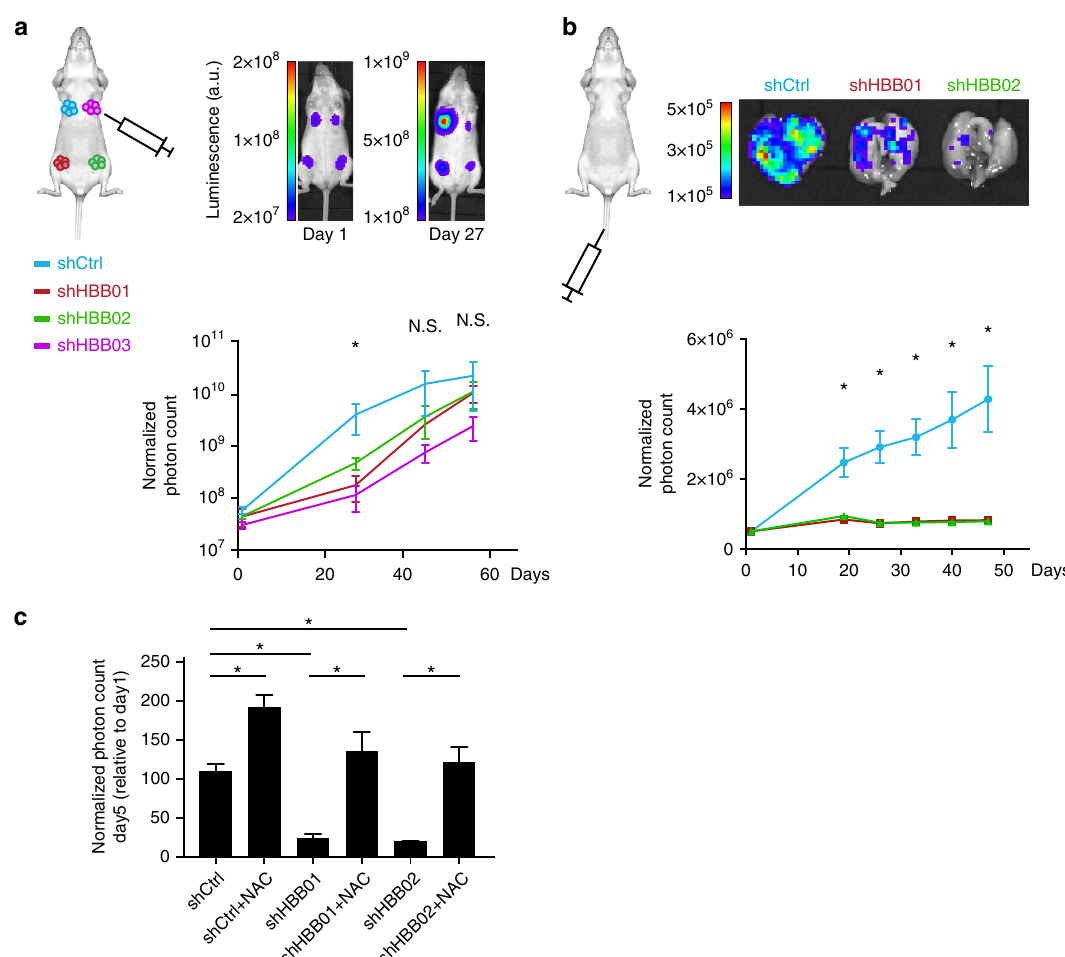
Figure 4 | HBB expression enhances the ability of breast CTCs to form distant metastases. ( a ) Orthotopic inoculation of 200,000 BRx50 CTCs into the mammary fat pad showing transiently delayed primary tumour formation upon HBB -depletion. Top : representative images of mice at day 1 and day 27 following tumour inoculation (luminescence by IVIS imaging). For each mouse, the mammary fat pad seen in the upper left of the image received control CTCs, while the other three fat pads received CTCs expressing three different shRNA constructs targeting HBB . Bottom: Primary tumour growth curves from mice orthotopically implanted with BRx50 CTCs expressing either control or HBB shRNAs. The transient but significant reduction in tumour size at day 27 is resolved in subsequent time points. ( b ) Intravenous injection of BRx50 cultured CTCs into the mouse tail vein, showing